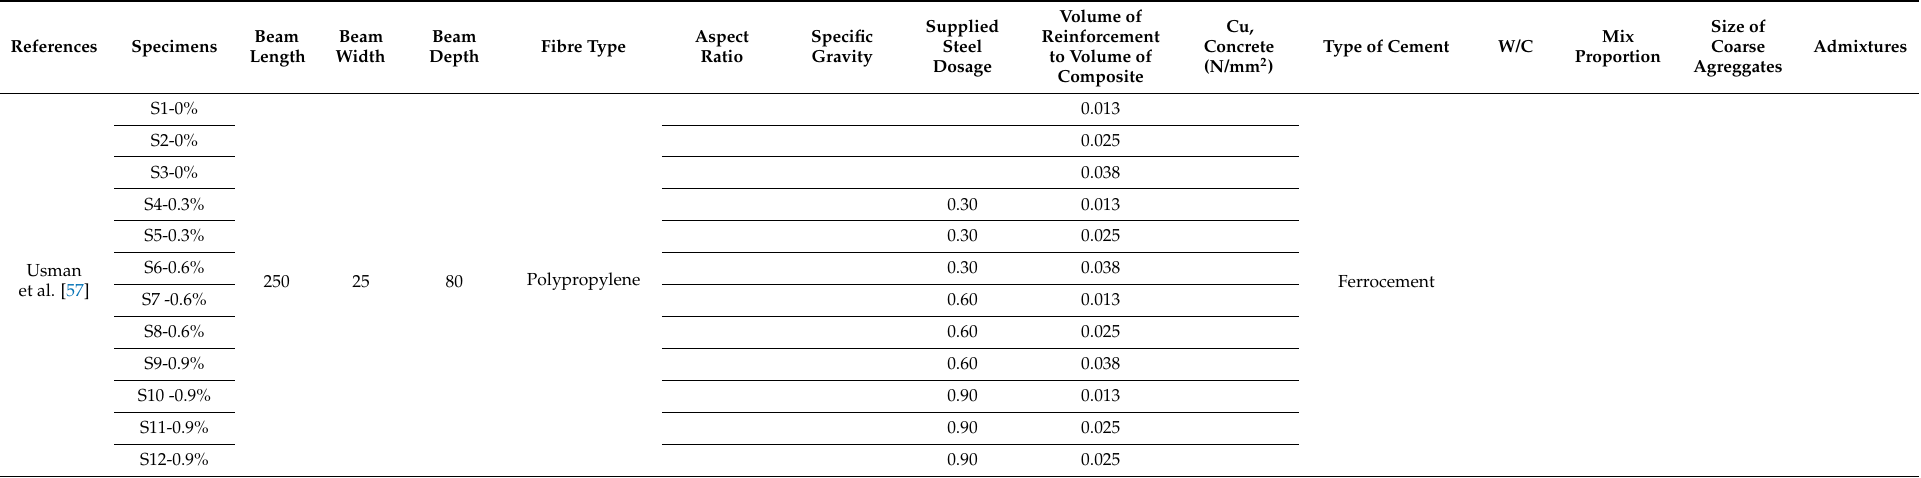
Table 2. Methods of preparation of synthetic fibre reinforced concrete from previous